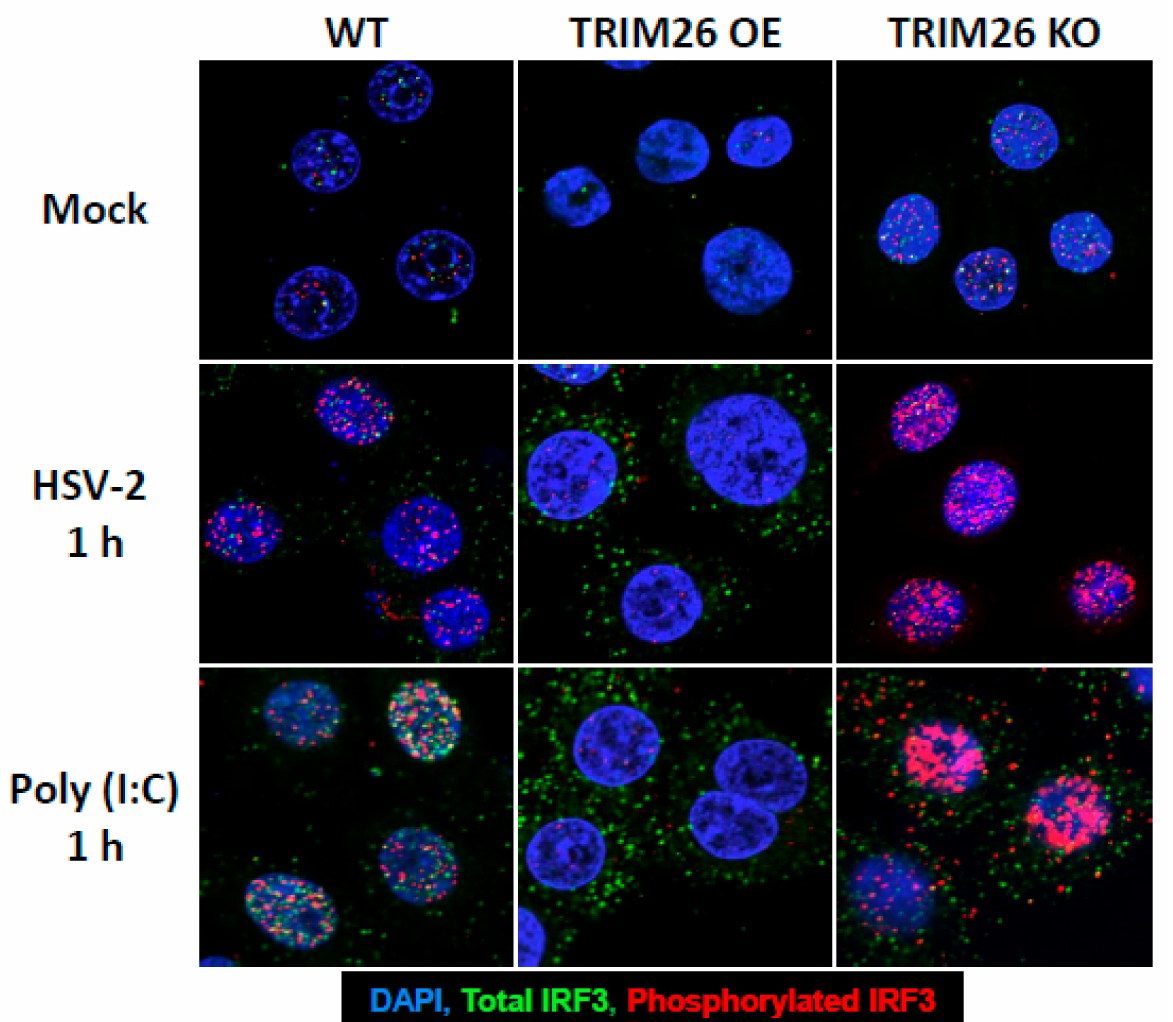
Figure 5. TRIM26 expression negatively regulates activation of IRF3. WT VK2, TRIM26 OE and TRIM26 KO cells were left uninfected (mock) or infected with HSV-2 or treated with Poly I:C, for 1 h. Cells were then fixed and stained as indicated in the colour guide below: DAPI (blue) total IRF3 (green), or phosphorylated IRF3 (pIRF3) (red). Occasional colocalization stain (yellow) in nuclei indicates IRF3 and pIRF3 are colocalized. Images were captured on confocal microscope Representative images are shown. Magnification ×